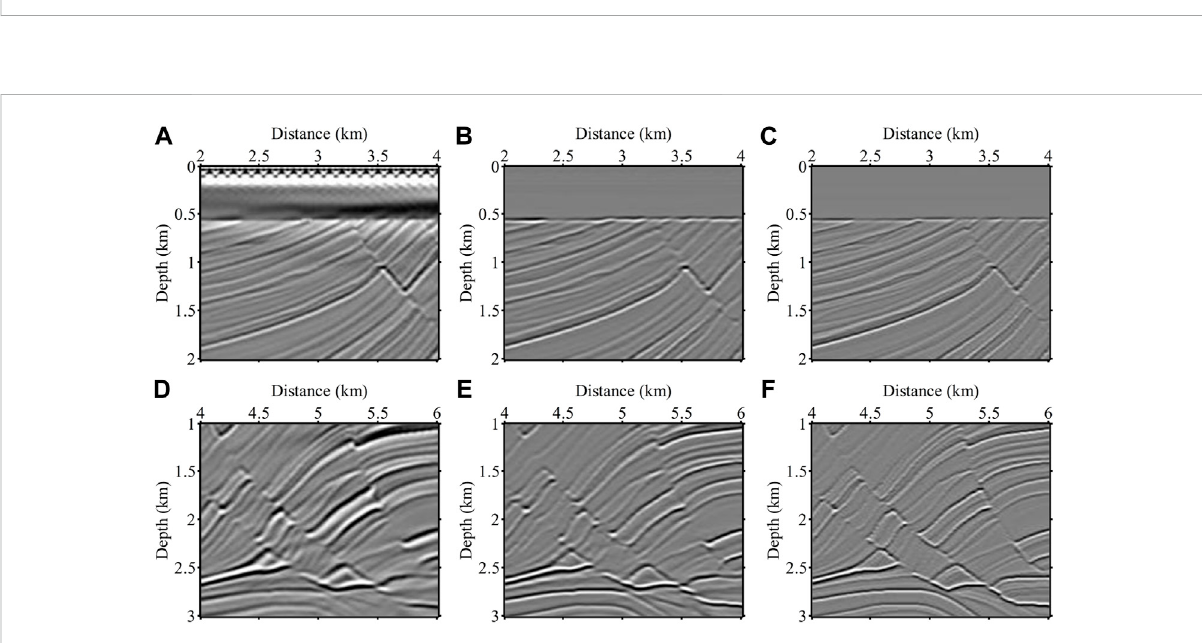
FIGURE 9 The zoom views of the red dashed boxed area in Figure 8. The fi rst column represents the RTM results (A,D) , the second column denotes the predictions (B,E) of the network and the third column is the true re fl ectivity model (C,F)